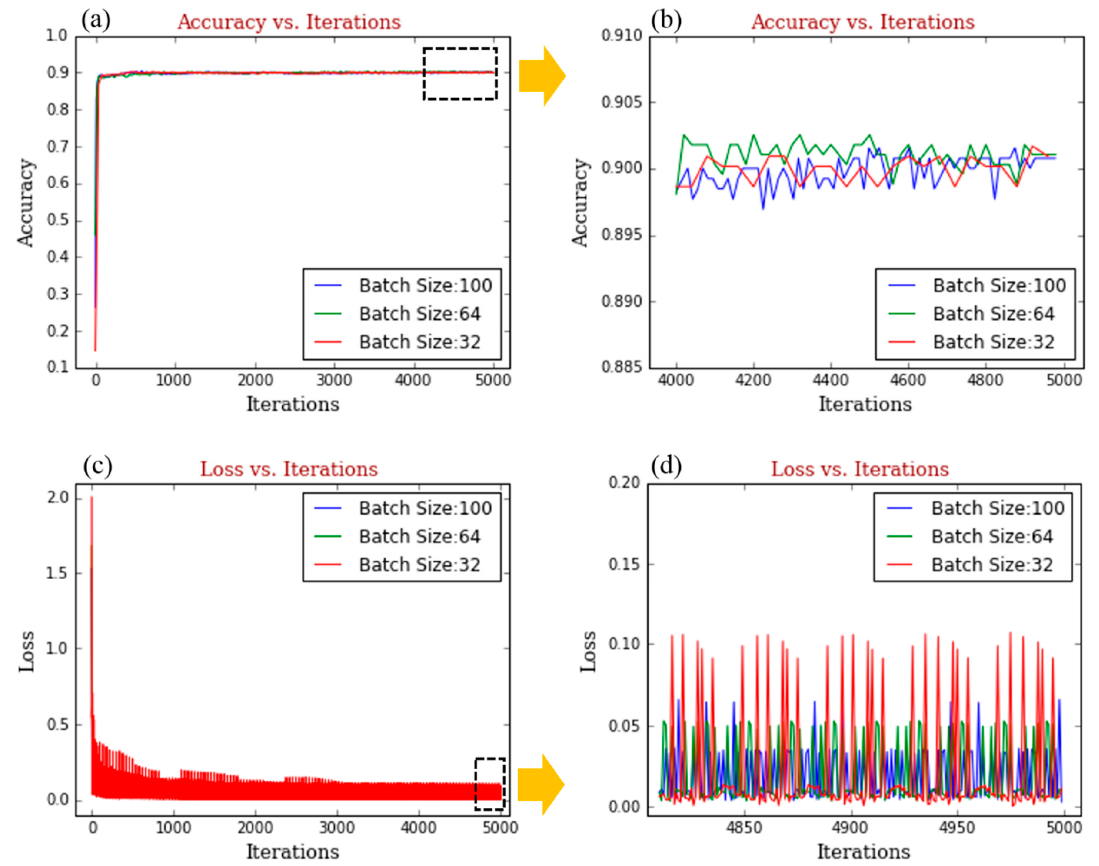
Figure 7. Accuracy and loss curves of different batch sizes. ( a , b ) showed the change of accuracy; ( c , d ) displayed the change of loss.